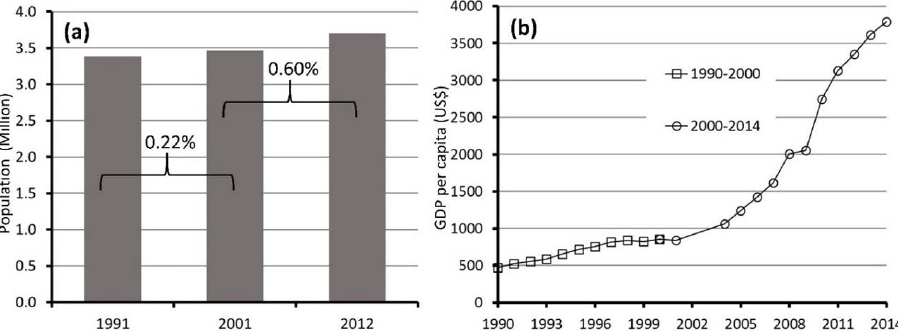
Figure 8. ( a ) APGR of the CMA (Data Source: Census data [36–39]); and ( b ) the GDP of Sri Lanka for various years [72]. Due to the lack of multi-temporal GDP data for the CMA, we used countrywide data as a proxy indicator. The CMA accounts for about 50% of Sri Lanka’s [9]. Note: GDP is in current US dollars.